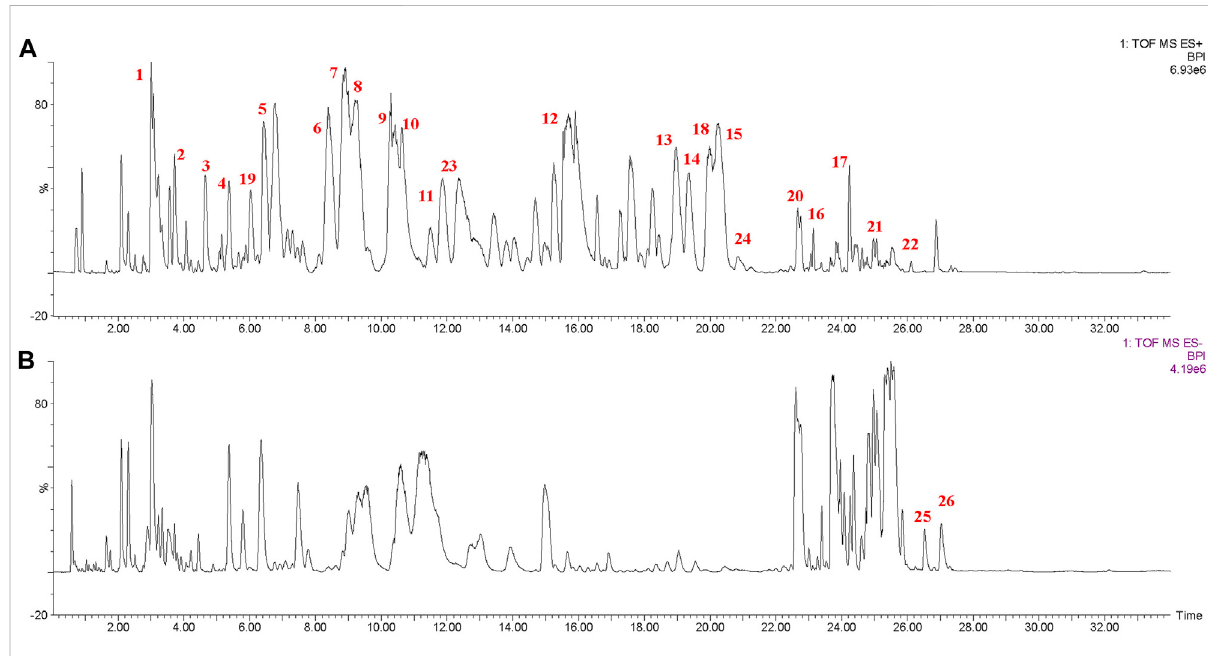
FIGURE 3 Base peak chromatogram of the PEF in positive (A) and negative (B) ion modes determined by the UPLC-Q/TOF-MS/MS method. 1, schisantherin E; 2, gomisin J; 3, schisandrin; 4, schisandrol B; 5, gomisin G; 6, schisantherin A; 7, schisantherin B; 8, schisanhenol; 9, gomisin F; 10, interiotherin A;11, schisandrinC; 12,deoxyschizandrin; 13, benzoylgomisinO;14, angeloylgomisin H; 15,angeloylgomisin O;16, schisantherinD;17, gomisinM2;18,d-epigalbacine;19,pregomisin;20,schisphenthinA;21,kadsuricacid;22,kadsuricacid3-methylester;23,schinalactoneA;24, sphenadilactone E; 25, lancifodilactone B; and 26, lancifodilactone